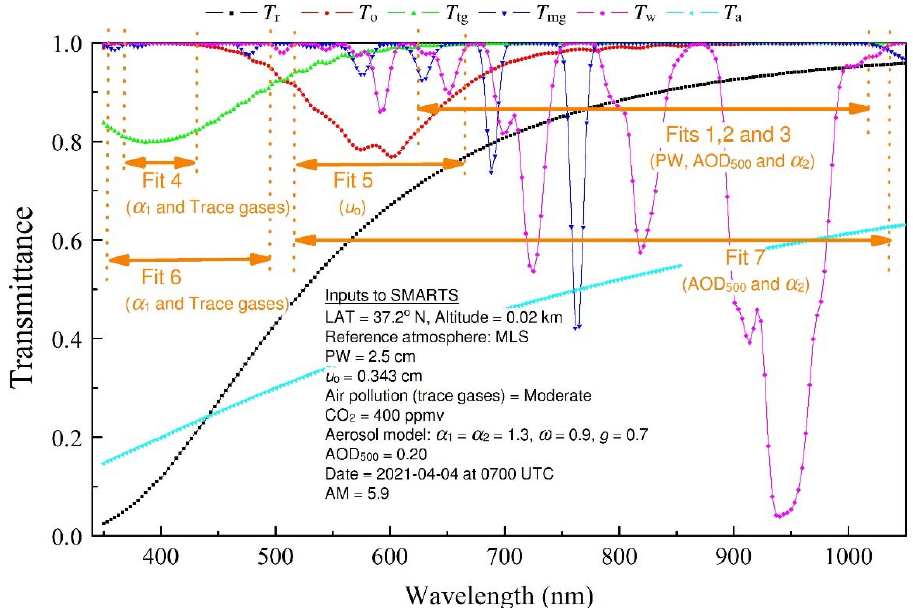
Figure 5. Atmospheric transmittances obtained using SMARTS for molecular scattering (Rayleigh scattering) T r , ozone absorption T o , trace gases absorption T tg , mixed gases absorption T mg , water vapor absorption T w , and aerosol extinction T a , per the colour code. The specific inputs are given explicitly. The orange arrows indicate the spectral bands selected for the determination of the atmospheric variables along with the order number of each fi tt ing process involved.